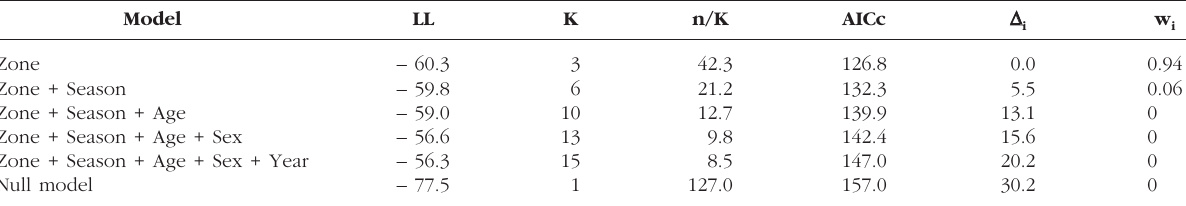
Table I. – Model selection to explain E. multilocularis infection with environmental and biological factors as descriptive variables.